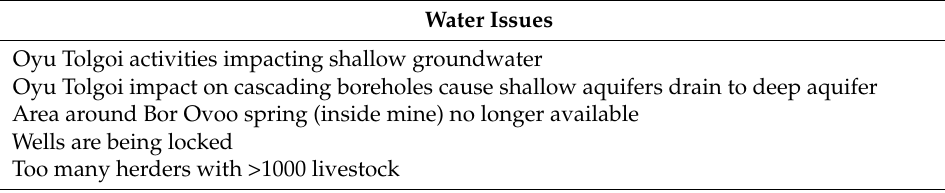
Table 3. Water issues identified by